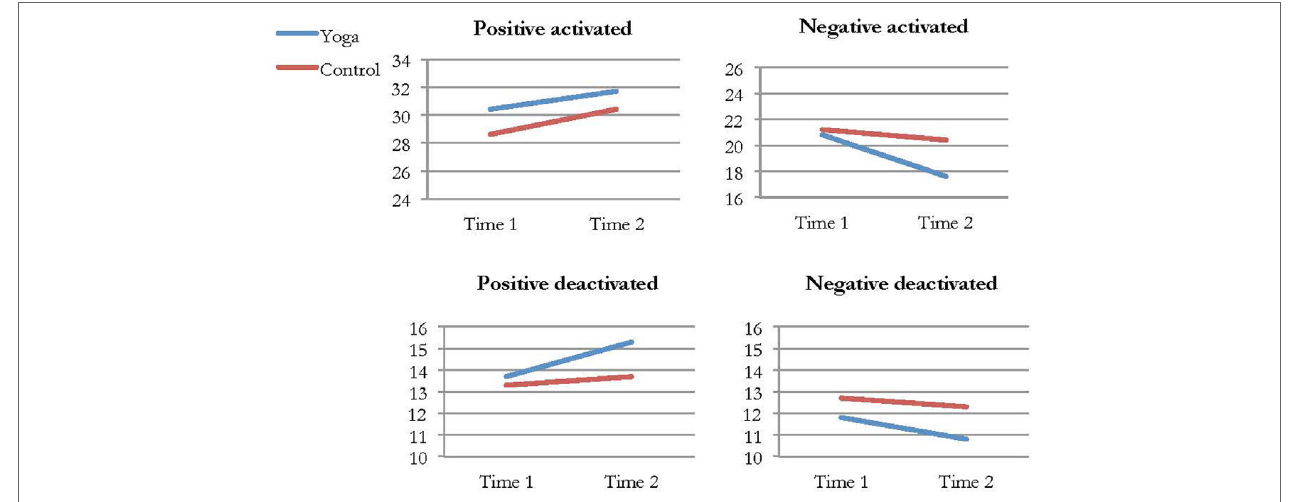
FigUre 3 | Average ratings of positive and negative activated and deactivated affect in the yoga and control group at Time 1 and Time